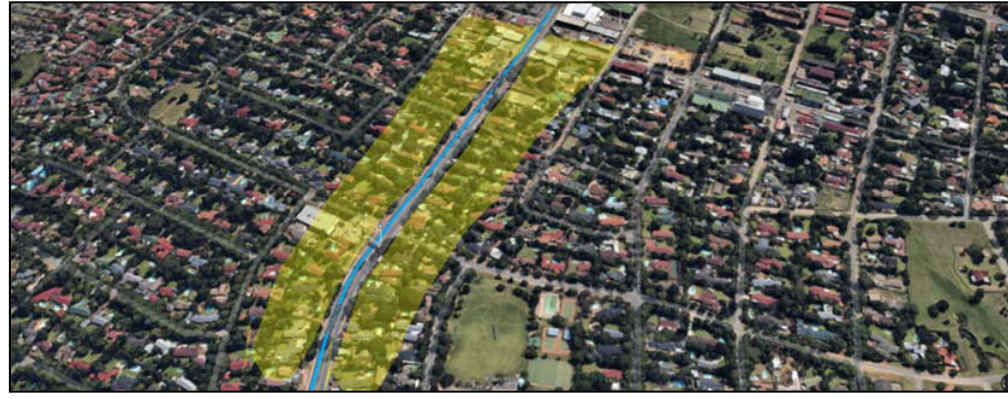
Figure 28. Coverage in Urban Area 60 km/h.